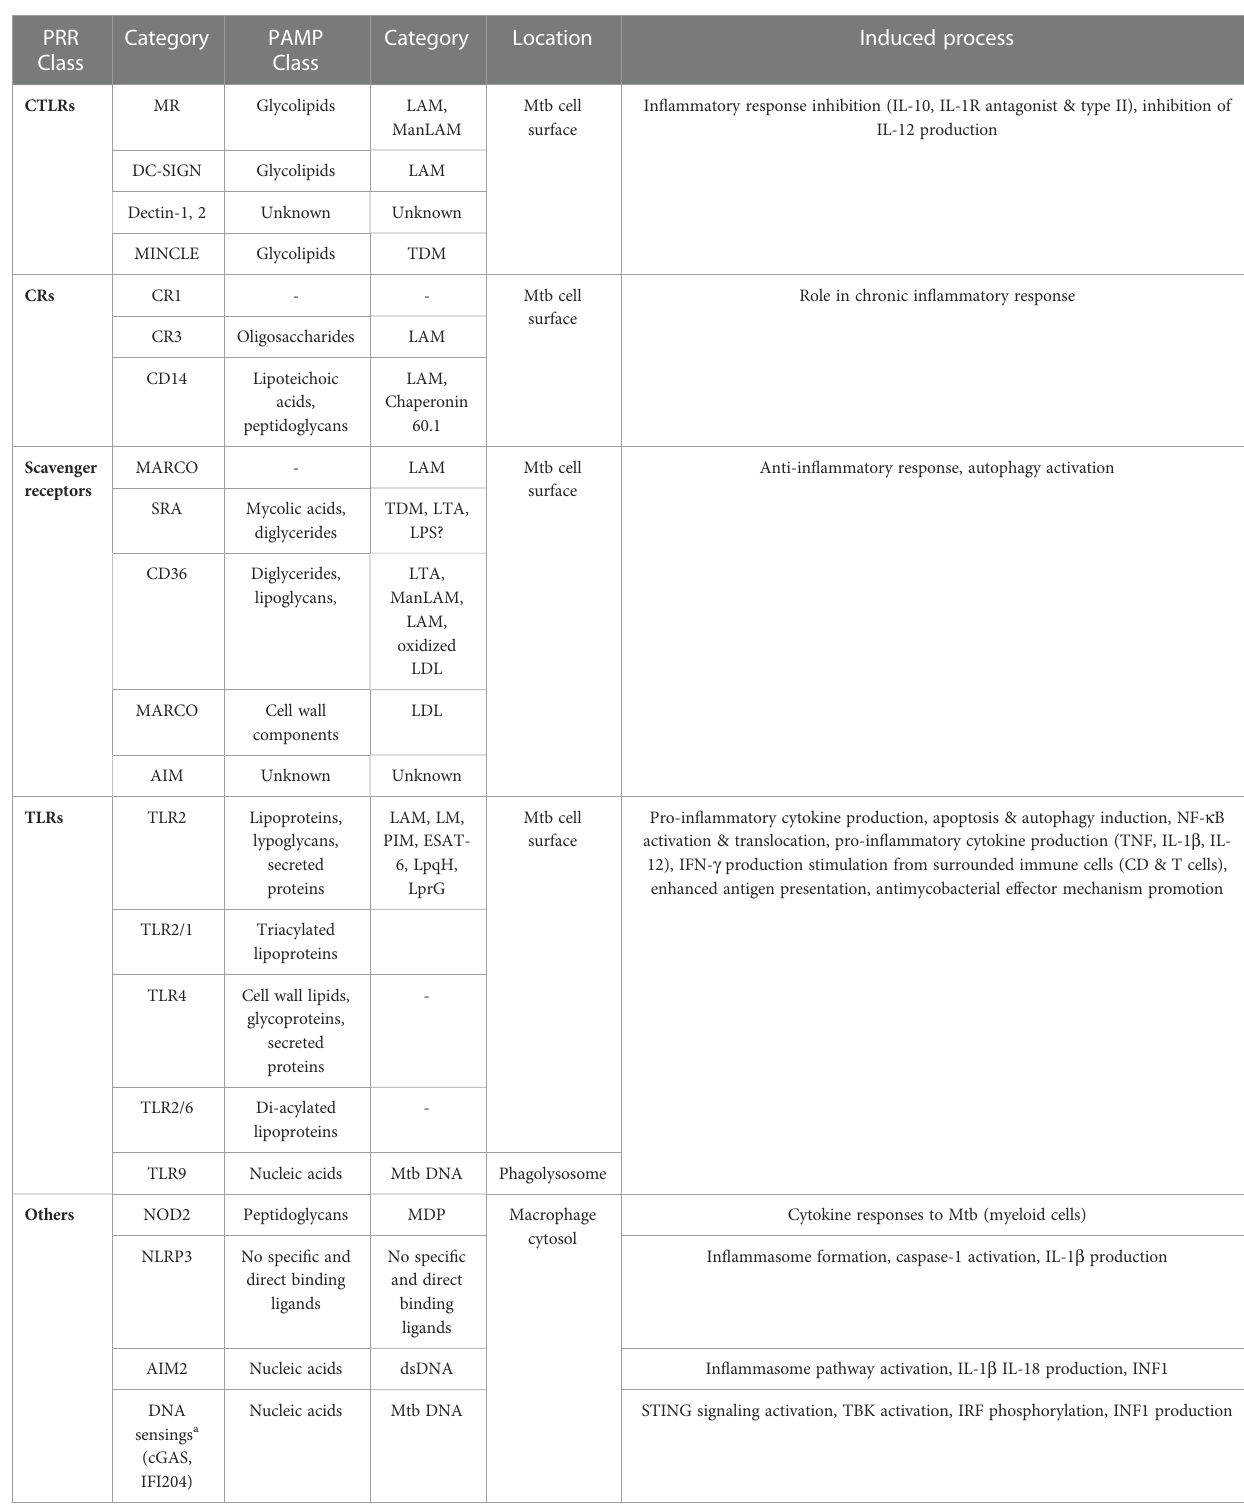
TABLE 1 Interaction between Mtb PAMPs and macrophage PRRs during recognition (Stamm et al., 2015; Ravesloot-Cha ́ vez et al., 2021; Tsolaki et al.,